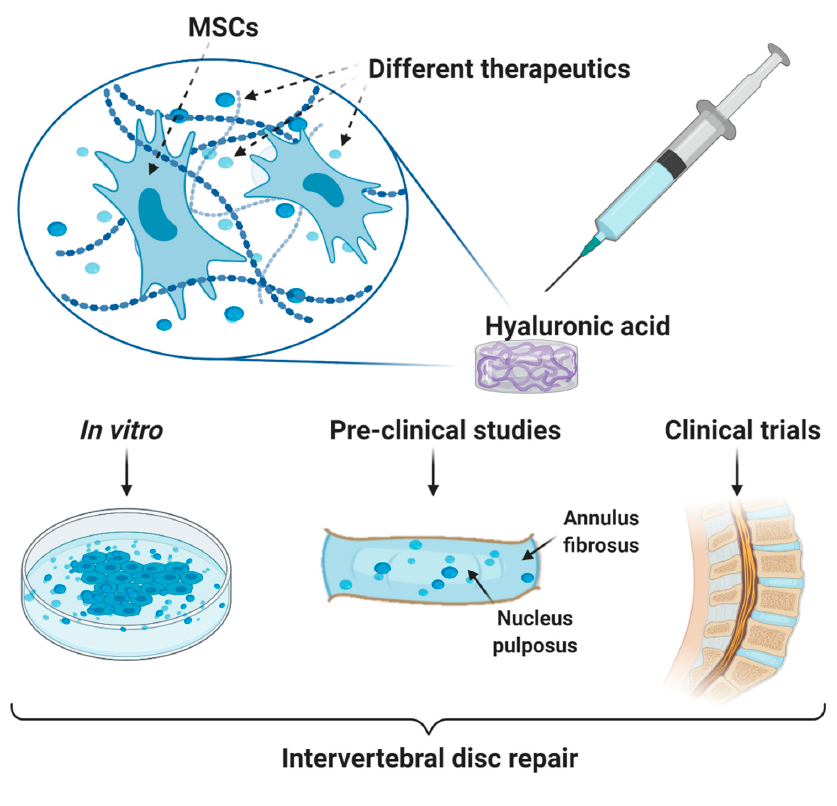
Figure 2. The role of hyaluronic acid as a platform for cell and drug delivery in the IVD. HA acts as a vehicle for adipose tissue and bone marrow isolated mesenchymal stem cells (MSC)s and drug delivery for disc repair. This schematic summarises the role of HA as a treatment for low back pain (LBP) and IVD degeneration in cell culture, preclinical studies and clinical trials. HA has been successful in disc repair through its anti-inflammatory, anti-apoptotic, analgesic and matrix modulatory